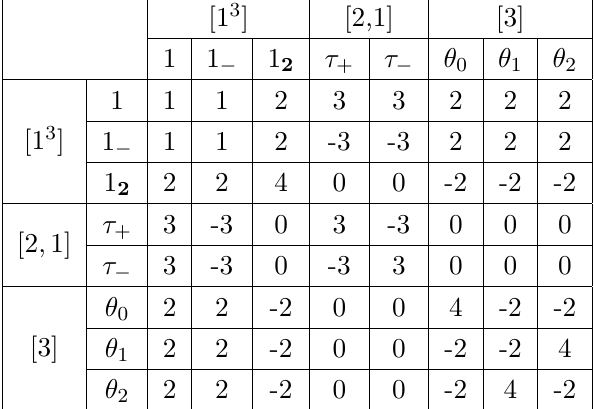
Table 1 . The S-matrix for the eight topological lines in S 3 gauge theory (multiplied by an overall factor of 6